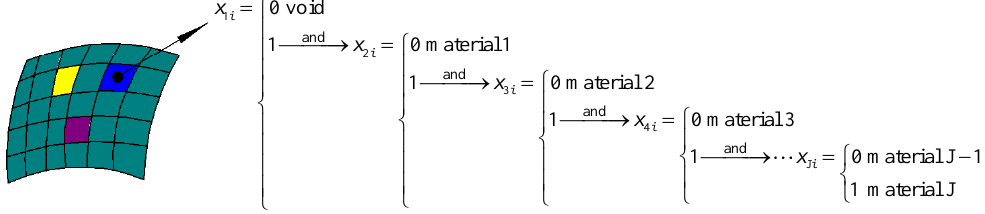
Figure 2. Characterization of multi-material-recognizing interpolation scheme.